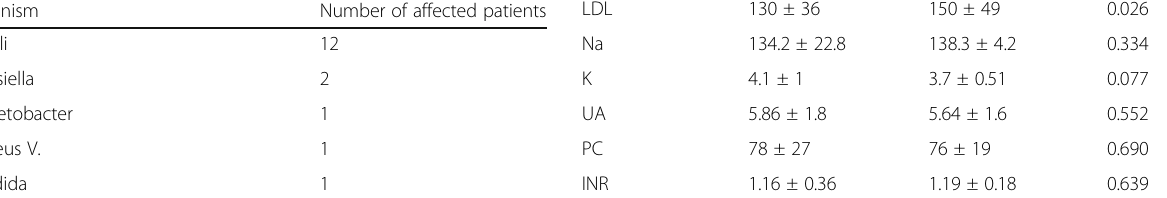
Table 5 Pathogens responsible for UTI in our study patients Organism Number of affected patients